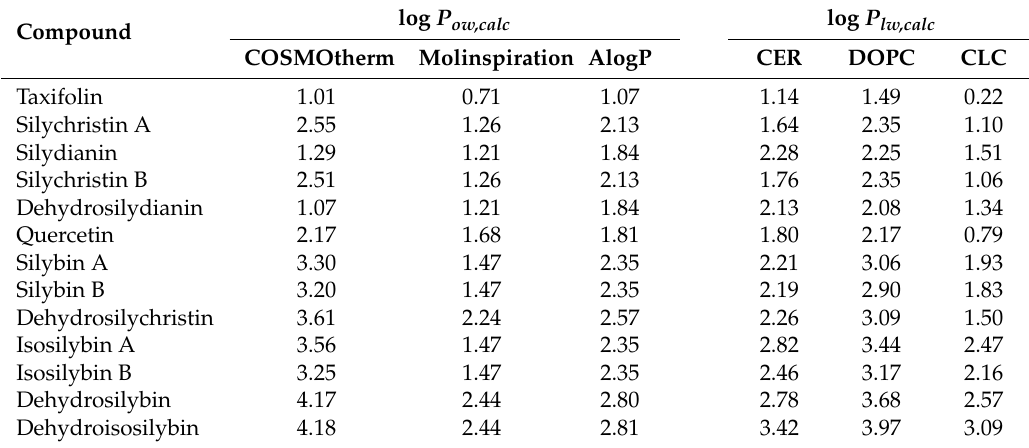
Table 2. Hydrophobicity of studied compounds predicted by computational tools as octanol/water partition coefficient (log P ow,calc ) and lipid/water partition coefficient (log P lw,calc ) in membrane models. log P ow,calc log P lw,calc Compound COSMOtherm Molinspiration